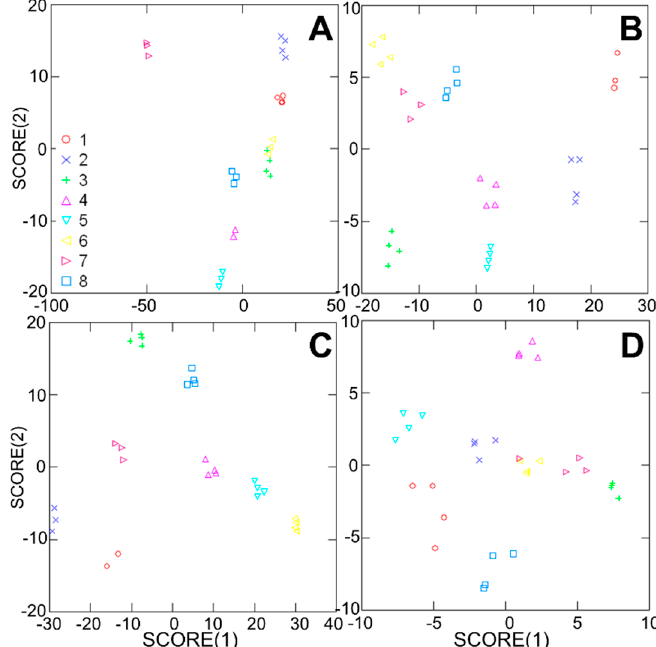
Figure 8. Linear discriminant analysis of fluorescence responses of analytes 1 – 8 with fluorophore 9 in ( A ) Newport snow; ( B ) Providence snow; ( C ) Kingston snow; and ( D ) deionized water, using cyclodextrins as predictors.